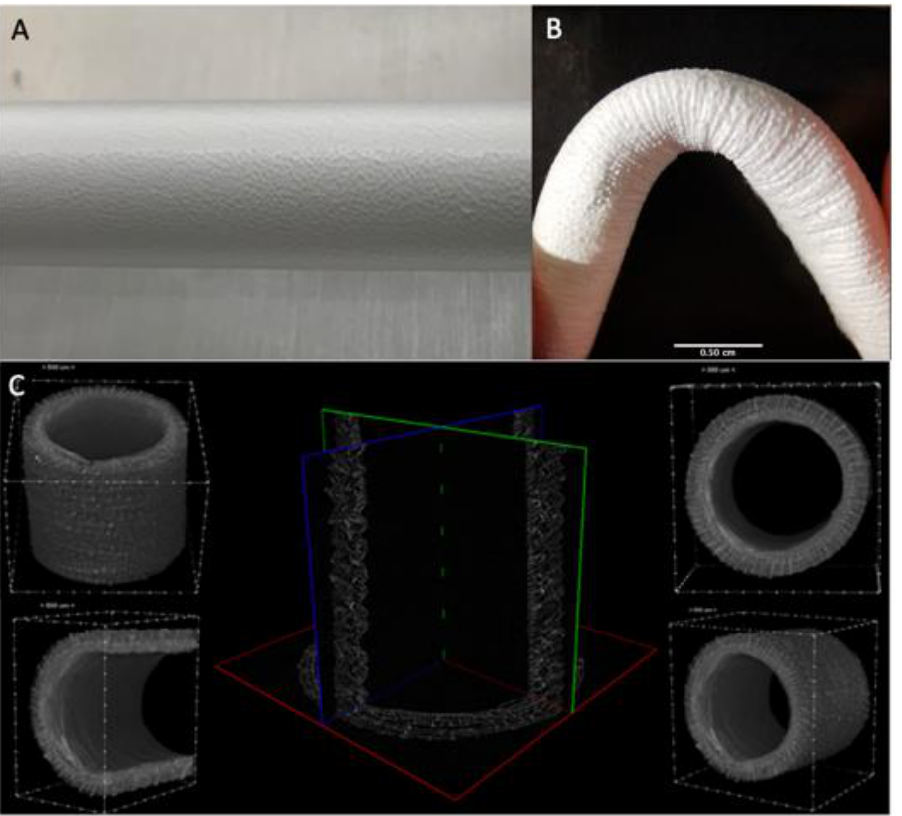
Figure 2. ( A ) Details of the ES deposition on the rotating collector ( B ) Kinking resistance of the graft at 84° ( C ) uCT analysis of the graft structure.